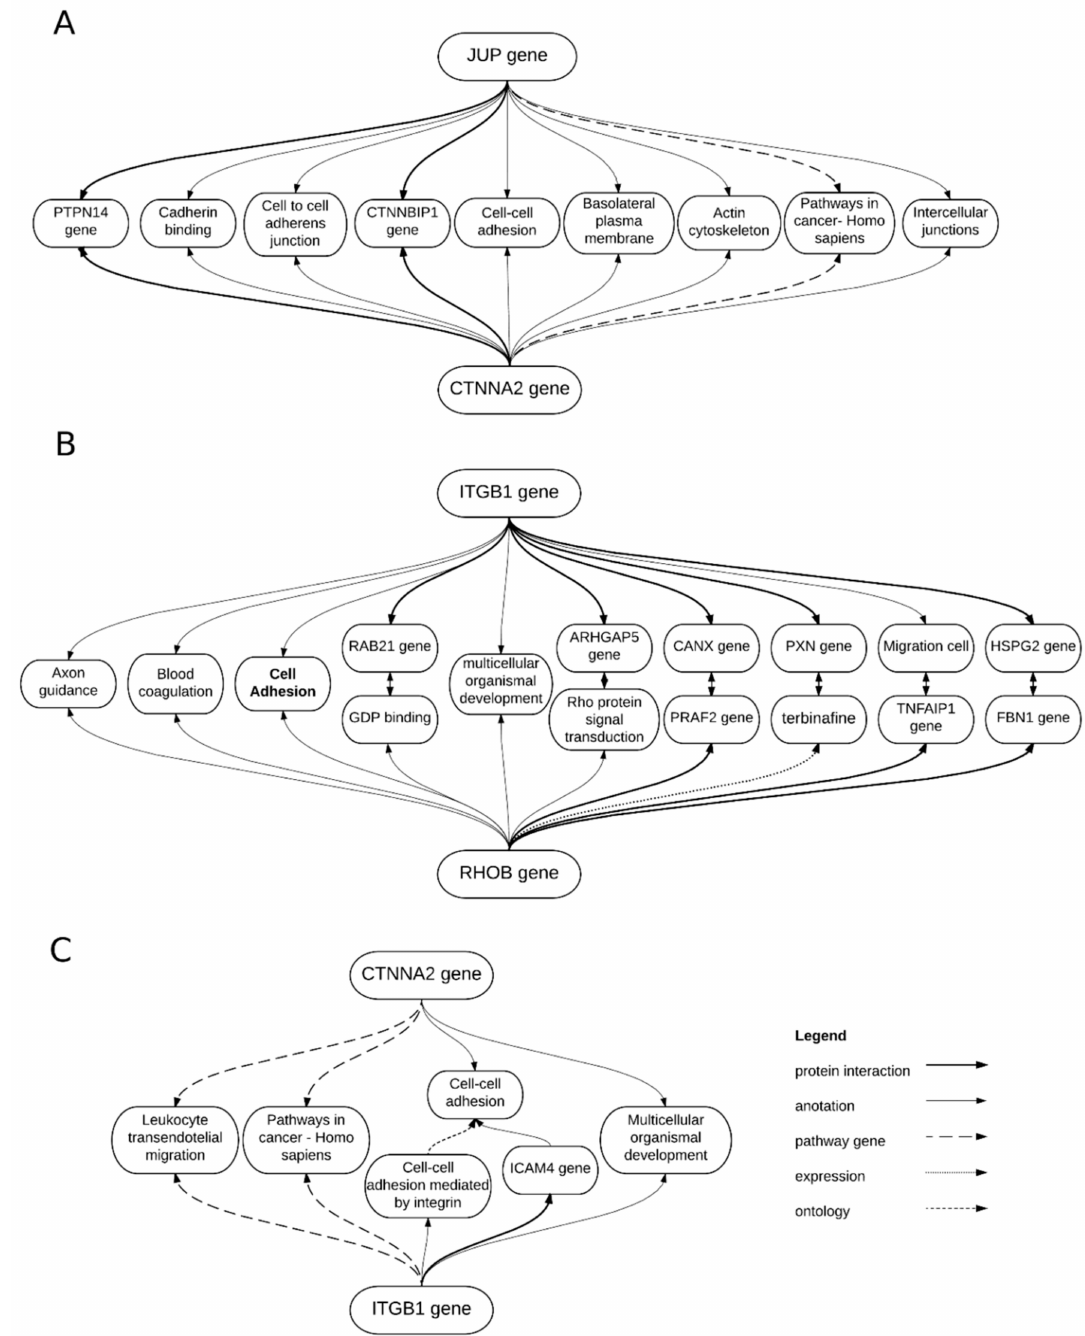
Figure 3. BioGraph gene interactions between ( A ) JUP and CTNNA2 , ( B ) ITGB1 and RHOB , and ( C ) CTNNA2 and ITGB1 , presenting their common processes and intermediating